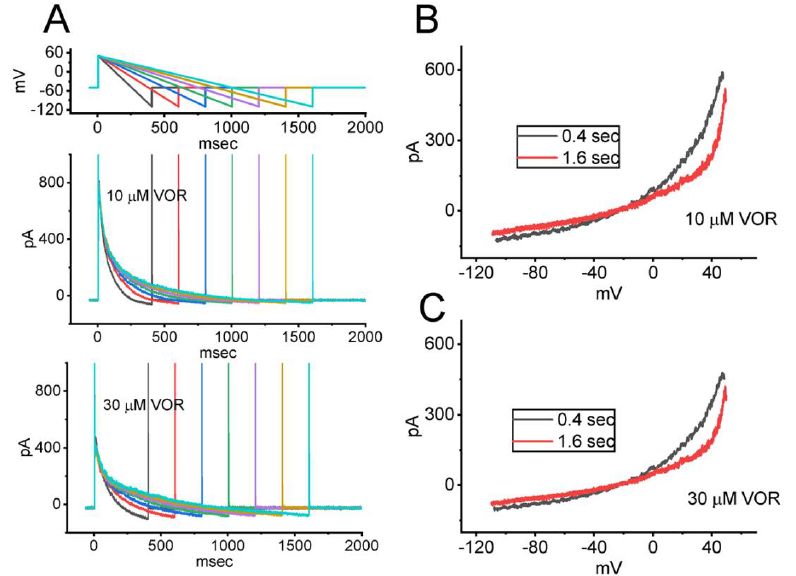
Figure 7. Effect of VOR on I K(DR) evoked by the descending ramp pulse with varying durations in GH 3 cells. In these experiments, the I K(DR) taken in the presence of 10 or 30 μM VOR was evoked by the depolarizing pulse from −50 to +50 mV followed by the descending (repolarizing) voltage pulse from +50 to −110 mV with varying duration ranging between 0.4 and 1.6 s (i.e., ramp slope between −0.4 and −0.1 V/s). ( A ) Representative current traces acquired during cell exposure to 10 μM VOR (upper) or 30 μM VOR (lower). The uppermost part indicates the voltage-clamp protocol applied. In ( B , C ), the relationships of instantaneous I K(DR) amplitude versus ramp voltage achieved with a ramp duration of 0.4 s (black color) or 1.6 s (red color) were respectively demonstrated in the presence of 10 and 30 μM VOR. Notably, as cells were exposed to VOR, during such downsloping ramp pulse, the current amplitude taken at the voltage range between −10 and +50 mV with the ramp duration of 0.4 and 1.6 s tends to be distinguishable; however, increasing VOR concentration from 10 to 30 μM significantly reduced I K(DR) magnitude with no evident change in the difference of current amplitude between different ramp durations applied (i.e., 0.4 and 1.6 s).